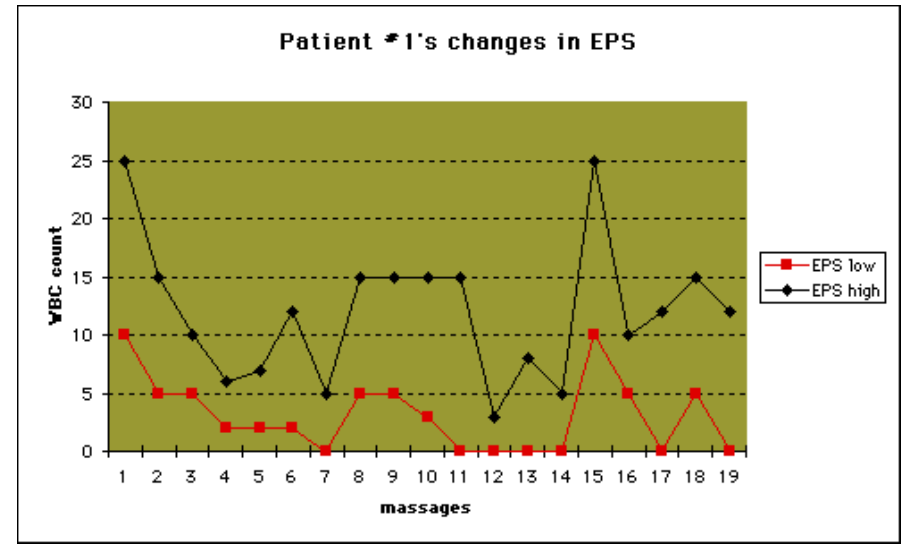
FIGURE 1 . Changes in the WBC counts of patient #1 over 19 prostatic